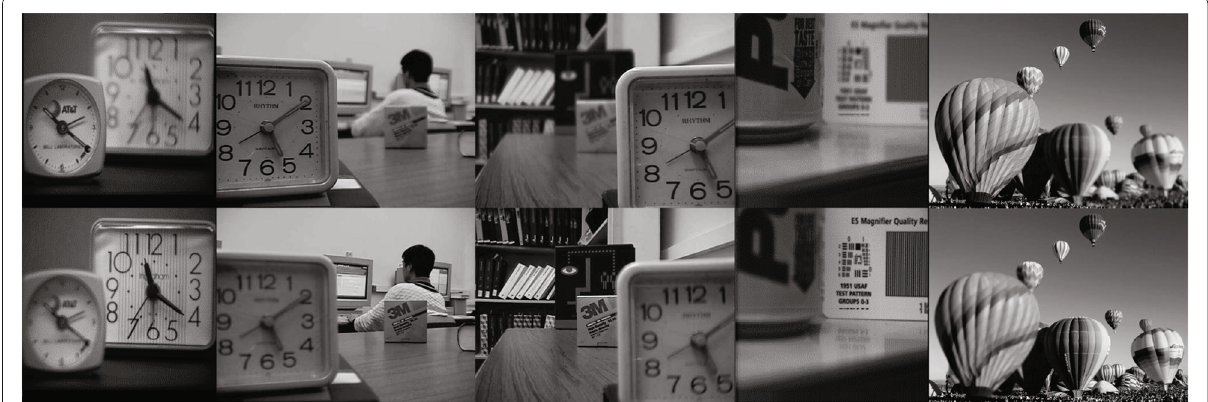
Fig. 14 Thumbnails of all five multi-focus image pairs used for evaluation